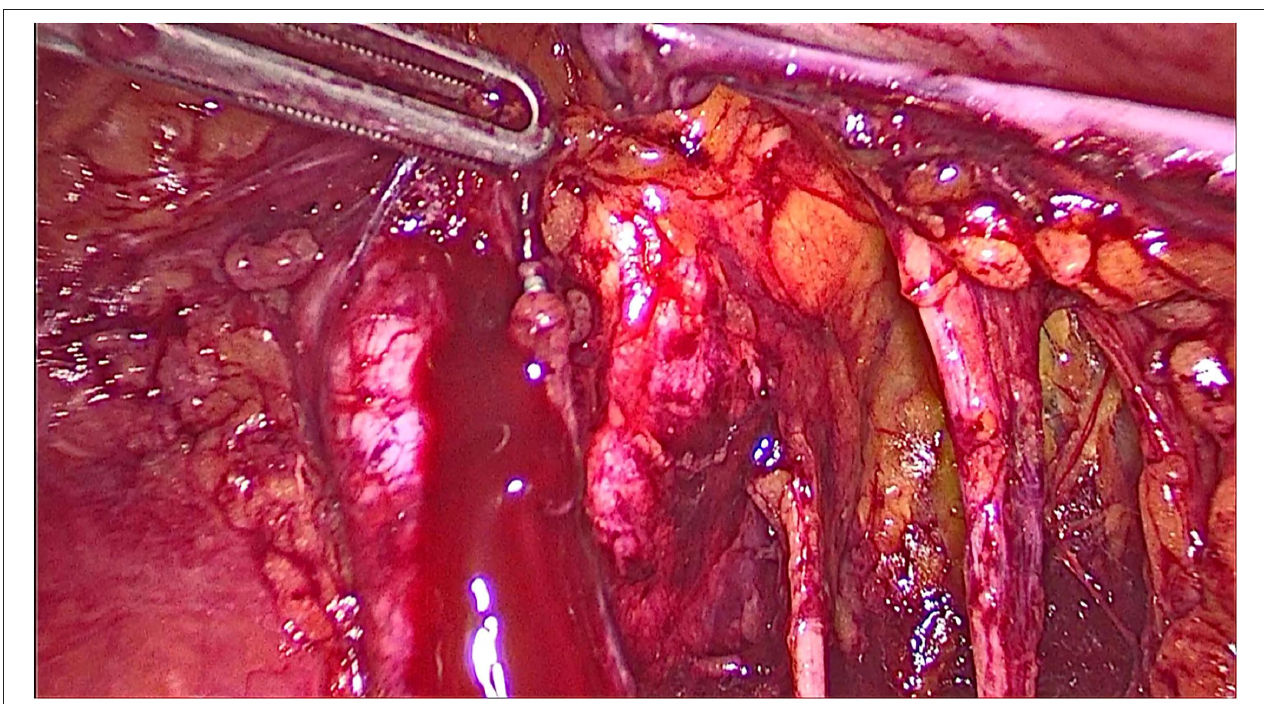
FIGURE 1 | A thermal injury at the medial surface of the left external iliac vein occurred while using the bipolar forceps during left pelvic lymphadenectomy.